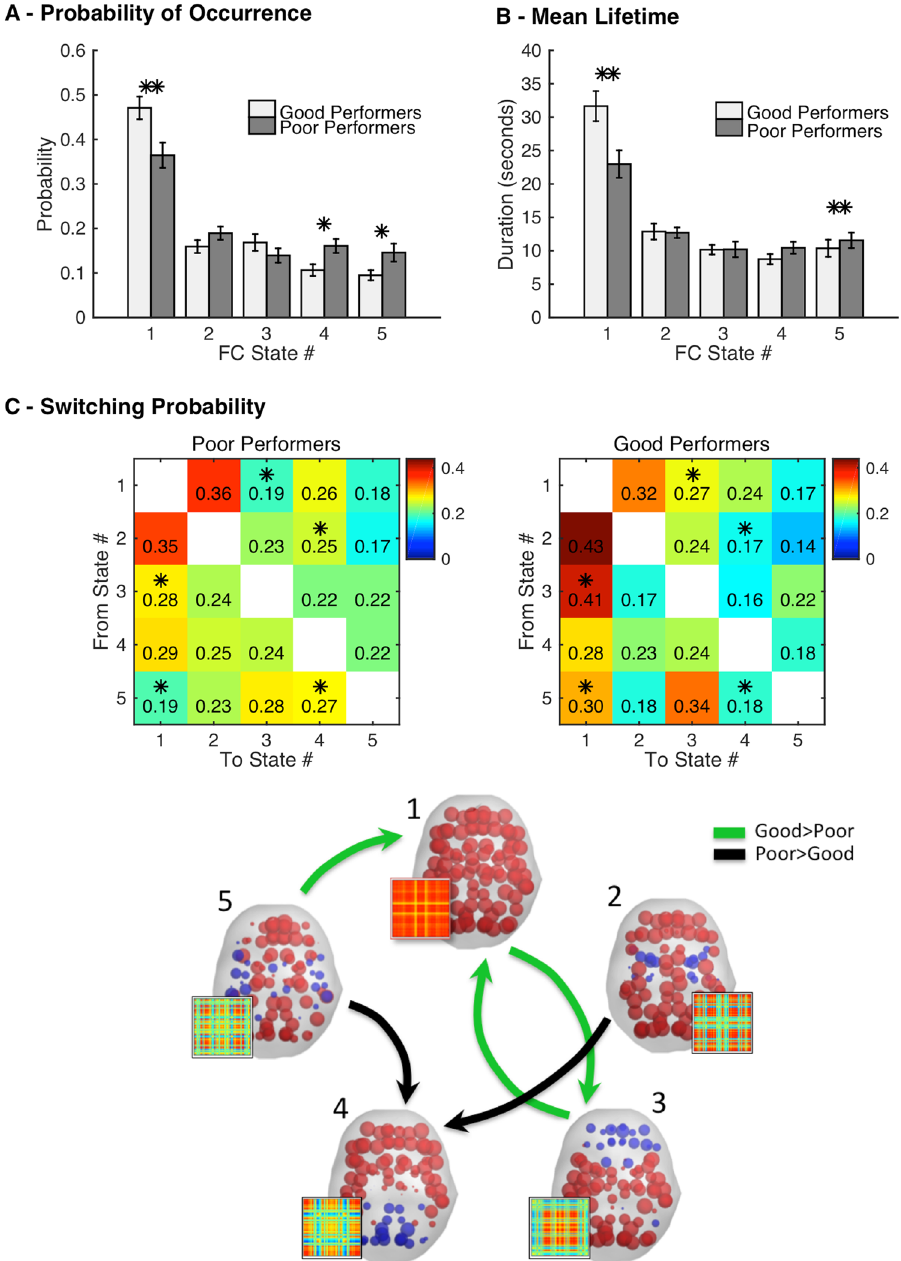
Figure 6. Switching between FC states relates with cognitive performance. ( A ) Fractional occupancy measured as the probability of occurrence of each state. The error-bars indicate the standard error. ( B ) Mean lifetime of each state. ( C ) Switching matrix indicating the probability of, being in a given FC state (lines), transitioning to any of the other states (columns). Significantly different transitions (p < 0.05) are illustrated in the plot below, with green arrows representing the transitions that occur with higher probability in good performers and in black the ones that occur with higher probability in poor performers. Each state is represented by the corresponding vector V C , displayed on cortical space (elements with the same sign in V c are colored alike). The corresponding FC pattern is illustrated on the side ( V c V cT , see Methods). In A-B-C, values were estimated for each subject and then a permutation-based paired t-test was applied to test for the between-group significance. ( * ) and ( ** ) indicate > 95% and > 99.5% confidence,